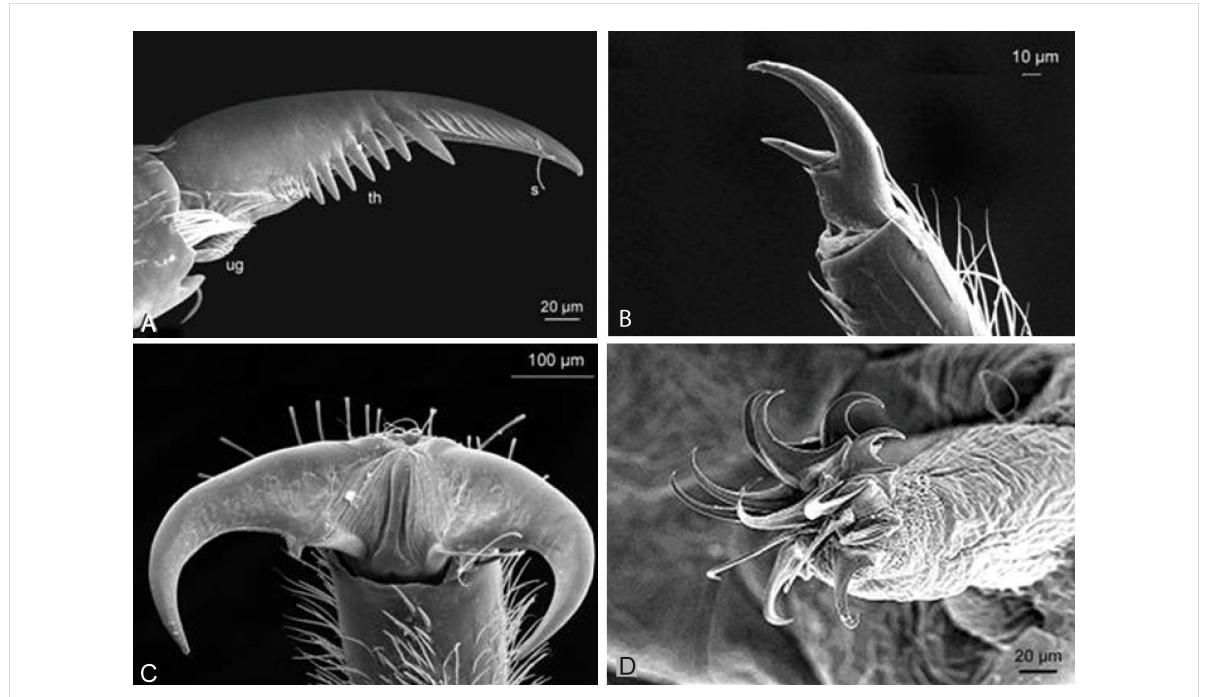
Figure 10: A) Tarsal claw of the mayfly larva Baetis vardarensis. Abreviations: ug unguitractor, th theeth, s sensilla. B) Tarsal claw of the second leg of caddies larva from Rhyacophila sp . dorsalis group, C) Double claws of the stream stonefly larva Perla marginata , D) Circlet of hooks on the proleg of a Chironomidae larva. Reproduced from